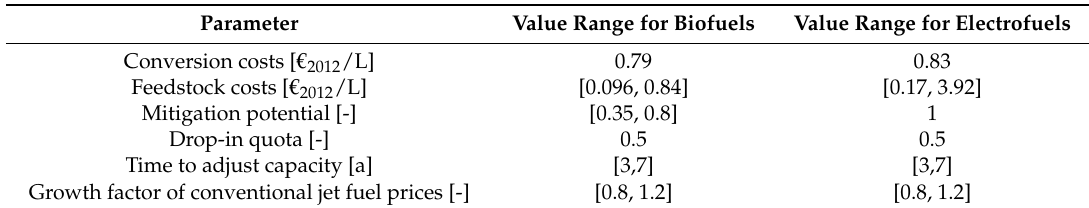
Table 1. Selection of parameters related to the adoption of alternative jet fuels that are altered in the simulation